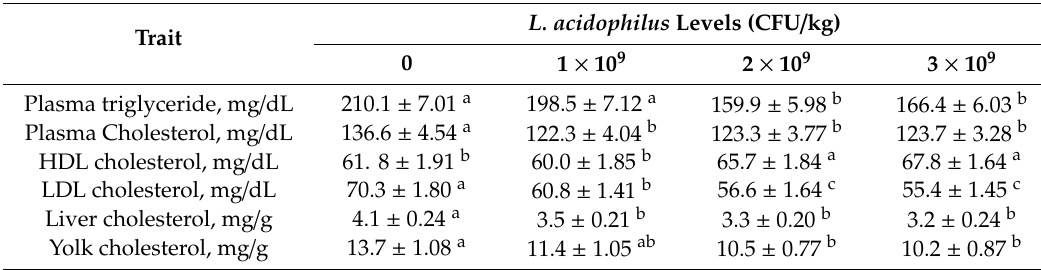
Table 2. E ff ect of dietary Lactobacillus acidophilus supplementation on plasma triglycerides and cholesterol levels in plasma, liver, and egg yolk of laying hens.